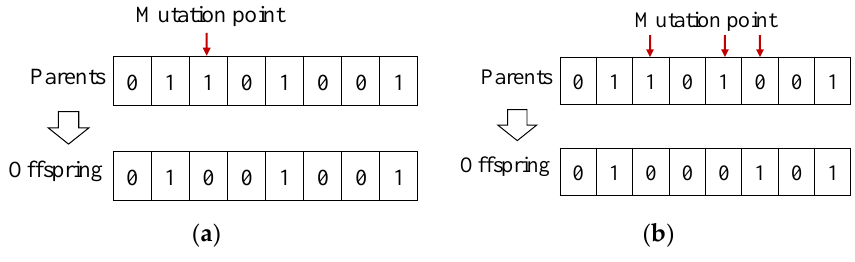
Figure 2. Examples of mutation for binary code: ( a ) Single-point mutation; ( b ) multipoint mutation.